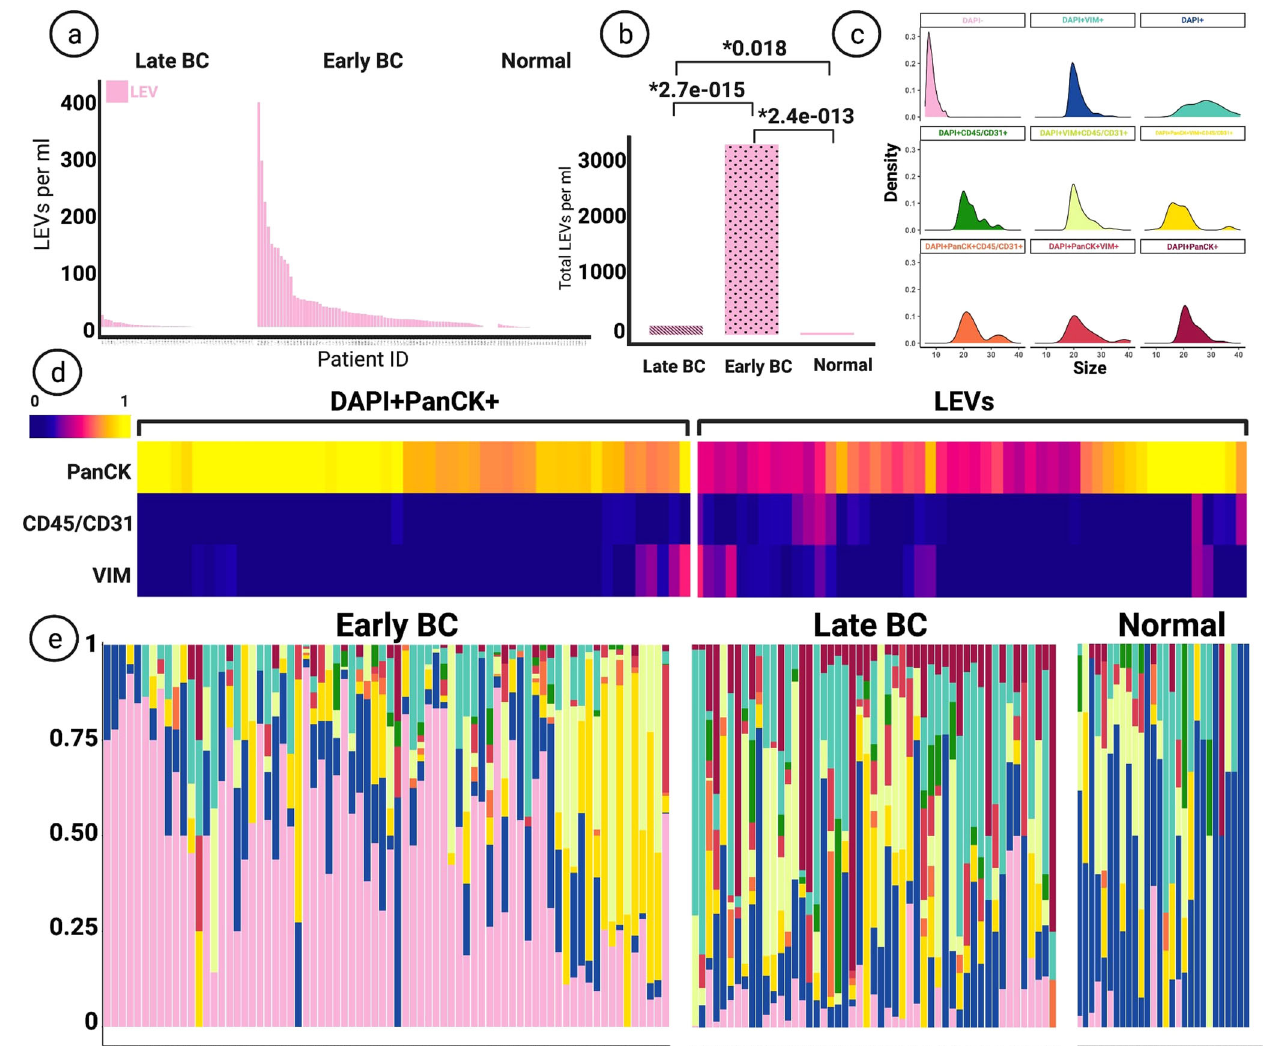
Fig. 3 Comparison of Tumor-Associated LEVs. a Frequency of enumerated LEVs between late-stage, early-stage, and the normal group based on channel classi fi cation. b Comparison of the distribution of LEVs between groups, Kruskal-Wallis H test (one-way ANOVA) performed. All p values below *0.05 considered statistically signi fi cant. c Size comparison of LEVs and rare cell events. All sizes represent diameters in micron. Sizes calculated by feature conversion from 100x images. d Heatmap displaying signal intensity of biomarkers on LEVs and DAPI + PanCK + cells. e Scaled frequency plots of rare cells and LEVs in patients, designated colors represent classi fi cation groups marked in the fi gure on panel c